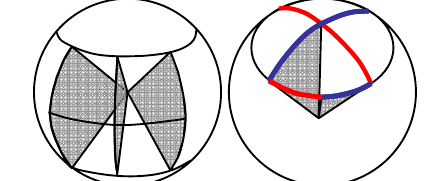
Figure 9. The partition curve surface corresponding to l